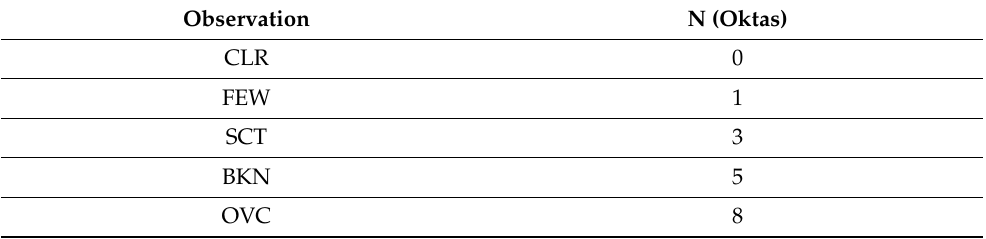
Table 2. Correlation between sky observation and cloud cover according to [29]. The abbreviations for sky conditions are the following: CLR = Clear; FEW = Few; SCT = Scattered; BKN = Broken; OVC = Overcast. Observation N (Oktas) CLR 0 FEW 1 SCT